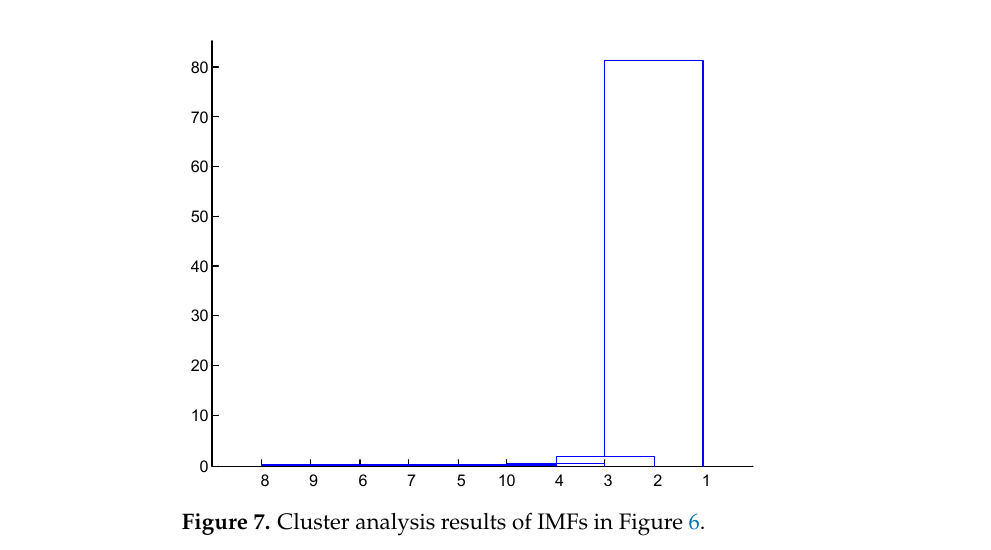
Figure 7. Cluster analysis results of IMFs in Figure 6.